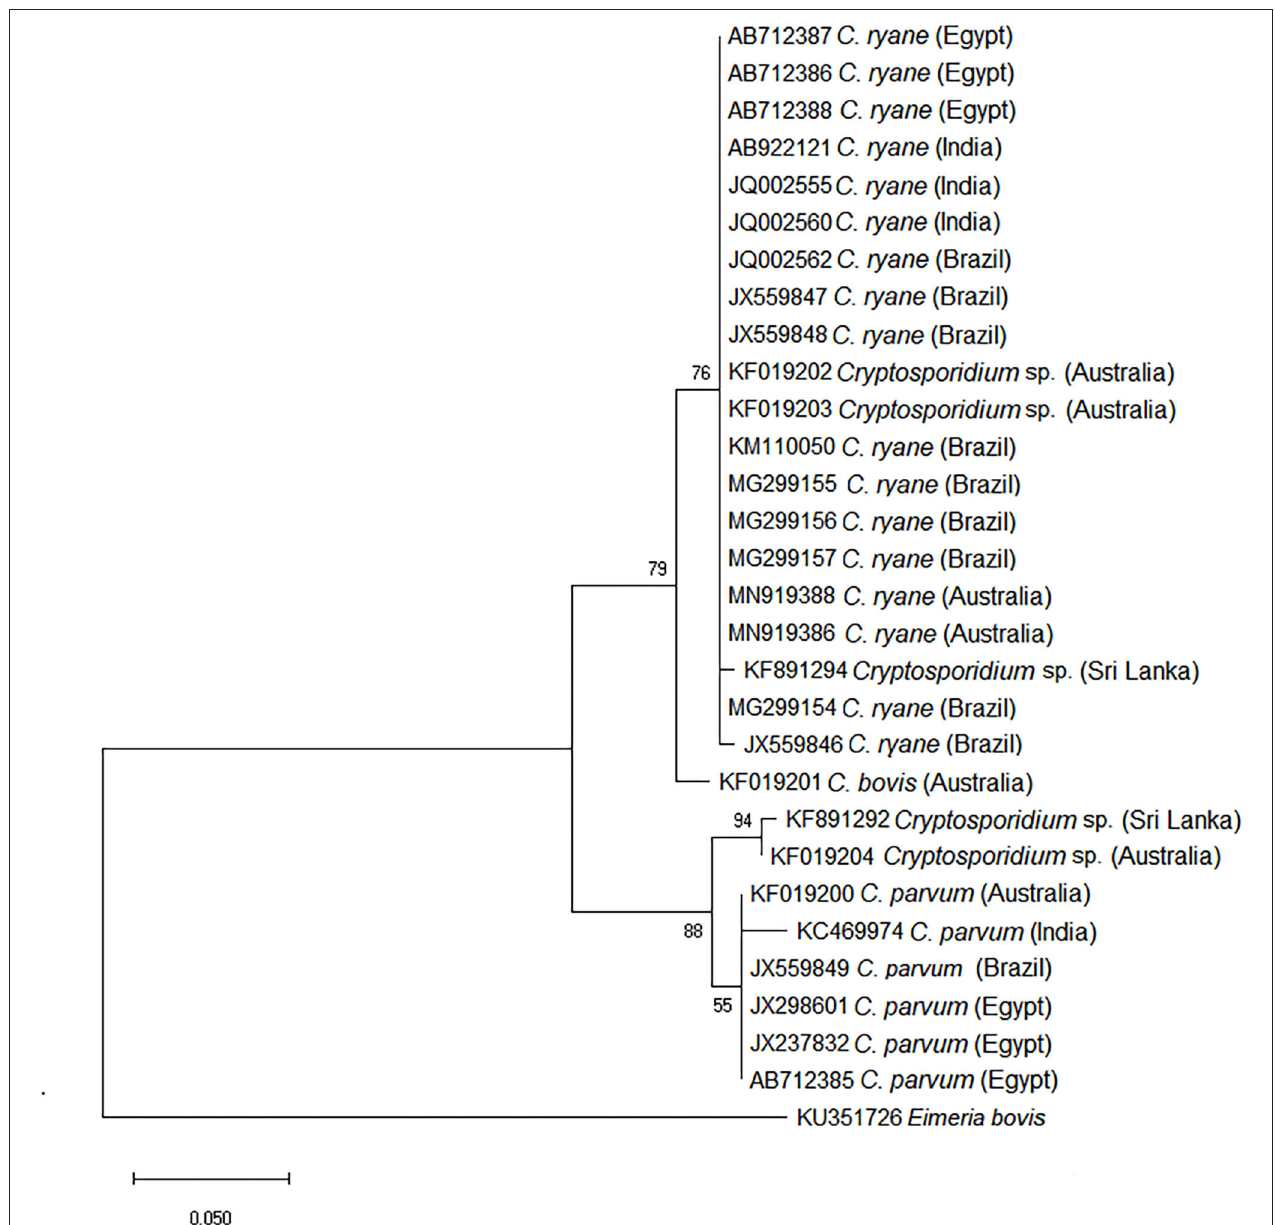
FIGURE 1 | Phylogenetic tree of species of Cryptosporidium using the ssu rRNA gene obtained from buffalo samples. The evolutionary history was inferred by using the maximum likelihood method and the Tamura–Nei model using MEGA software.